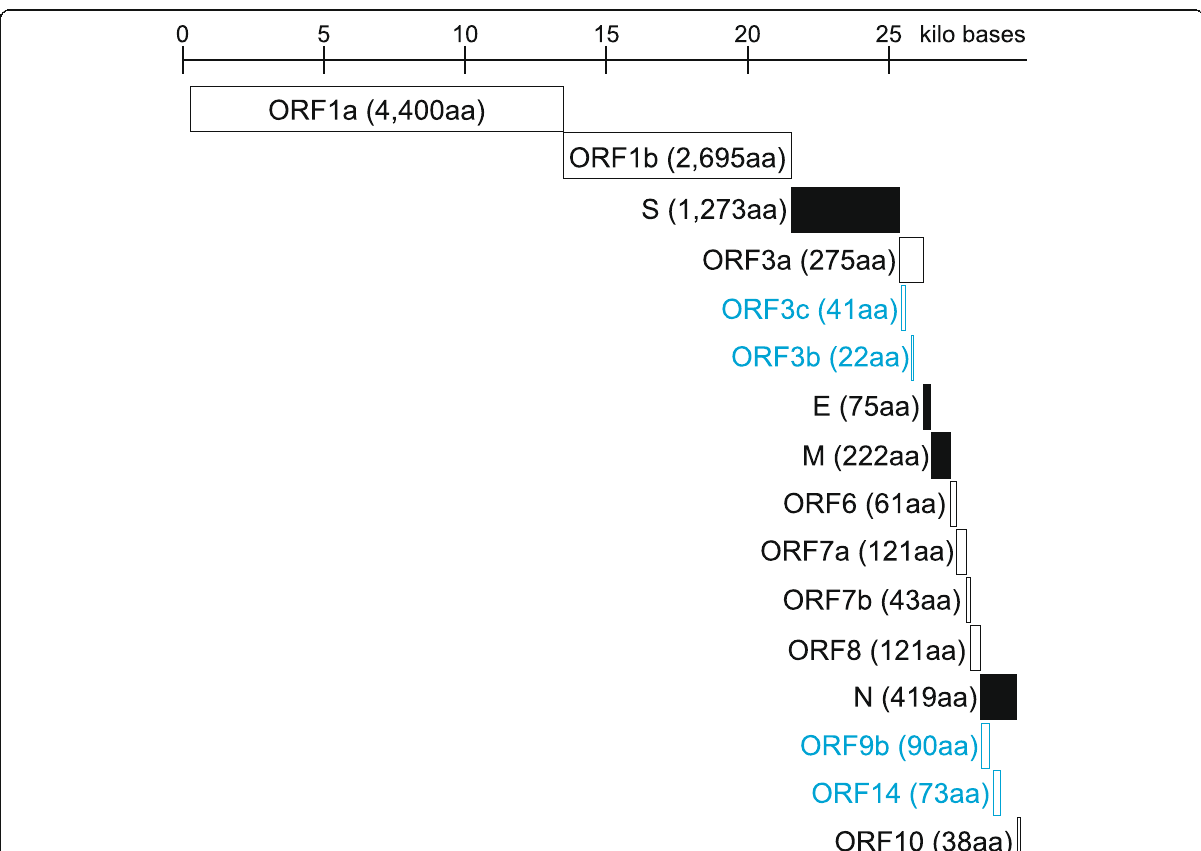
Fig. 3 Genomic structure of SARS-CoV-2. Schematic genomic structure of SARS-CoV-2 was shown based on the SARS-CoV-2 Wuhan-Hu-1 (NCBI Reference Sequence ID: NC_045512.2). The scale was shown on the top. Each ORF was illustrated based on the NCBI annotation of NC_045512.2, and a rectangle filled with black corresponds to a structural protein. The number in parentheses is the length of amino acid sequence (aa, amino acid). A gene name as well as rectangle colored in light blue was a hypothetical ORF which is not annotated NC_045512.2 currently. ORF3b is based on Konno et al. [15], and the others are based on Davidson et al. [16] and Jungreis et al.